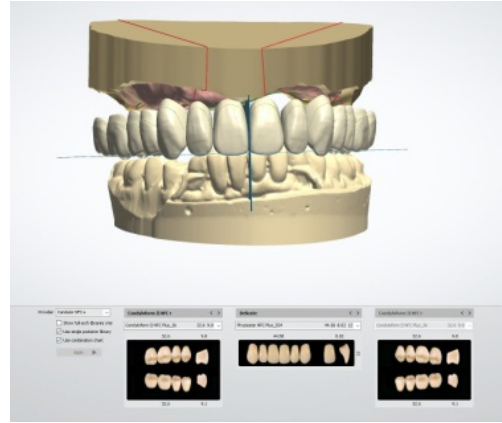
Figure 11. Tooth selection and draft arrangement.